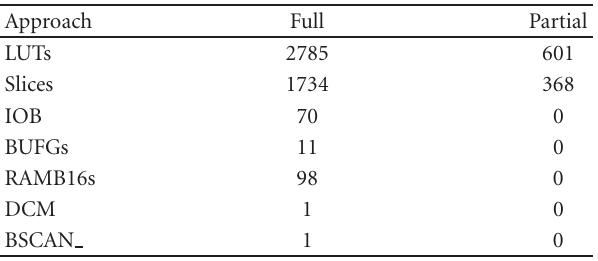
Table 9: GA Parameters used in